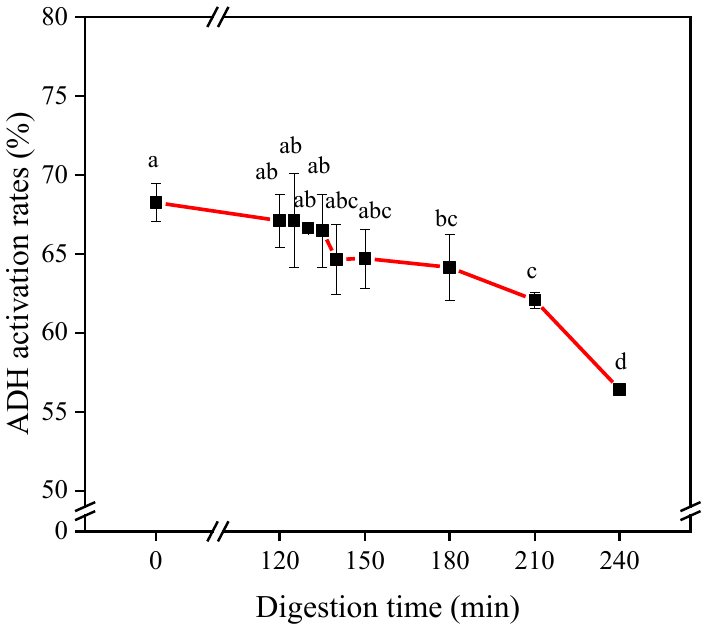
Figure 3. ADH activation rates of CPHs-Pro-30 at different concentrations after simulated gastric digestion (SGD) or simulated intestinal digestion (SID). (Different letters (a–d) represent significant differences in values).